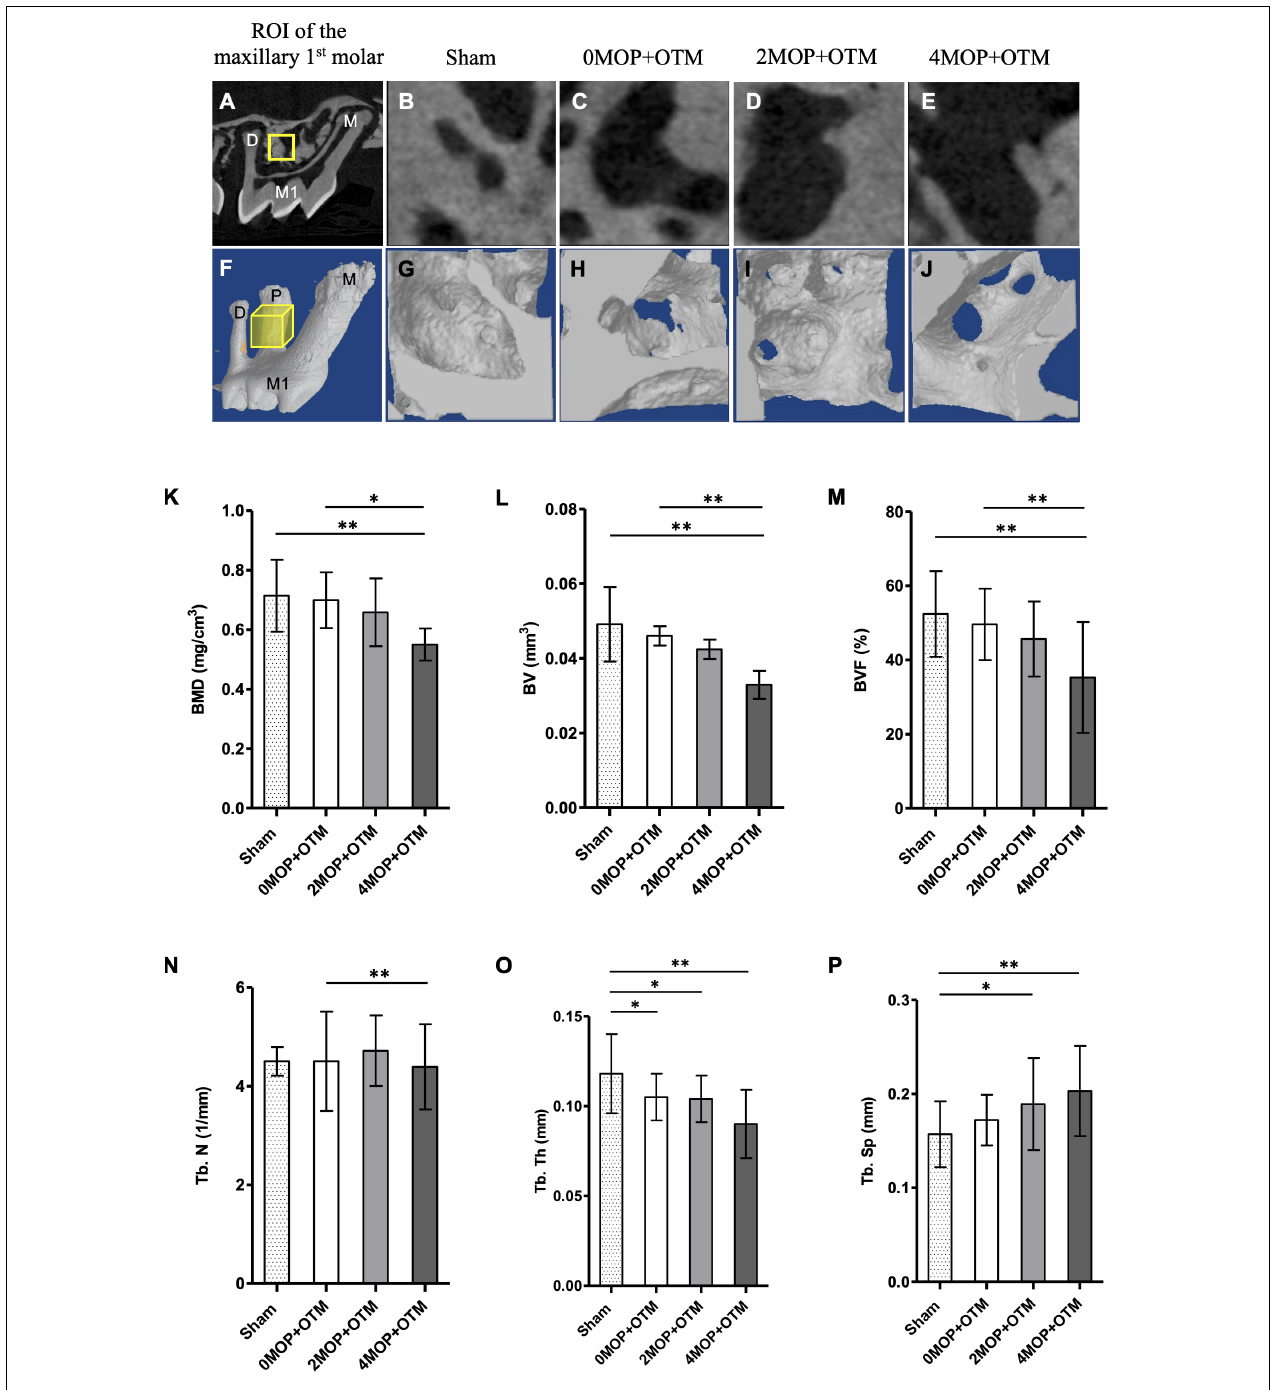
FIGURE 1 | Micro-CT analysis for bone quality. (A–E) Sagittal section image of micro-CT. The ROI (yellow square on A ) of alveolar bone quality for each group from (B–E) . (F–J) 3D reconstructed images of ROI (yellow cube on F ) of experimental groups. According to the volumetric analyses, (K) BMD, mg/cm 3 ; (L) BV, mm 3 ; (M) BVF, % decreased in the 4MOP+OTM group (0.55 ± 0.18 mg/cm 3 ; 0.03 ± 0.01 mm 3 ; 35.27 ± 14.94 %; p < 0.01) compared to the 0MOP+OTM group (0.69 ± 0.09 mg/cm 3 ; 0.04 ± 0.009 mm 3 ; 49.59 ± 9.62 %) and Sham group (0.71 ± 0.12 mg/cm 3 ; 0.04 ± 0.01 mm 3 ; 52.39 ± 11.55 %). (N) Additionally, the Tb. N, 1/mm was found to decrease in the 4MOP+OTM group (3.78 ± 0.89 1/mm; p < 0.01) compared to the 0MOP+OTM group (4.71 ± 0.71 1/mm). (O,P) Regarding changes in the Tb. Th, mm; Tb. Sp, mm were different between the 4MOP+OTM group (0.09 ± 0.01 mm; 0.20 ± 0.04 mm; p < 0.01) and Sham group (0.11 ± 0.02 mm; 0.15 ± 0.03 mm). In addition, the 2MOP+OTM group (0.10 ± 0.01 mm; 0.18 ± 0.04 mm; p < 0.05) was different compared with the Sham group. ( N = 12/each group) (M1, 1st molar; M, mesial; P, palatal; D, distal; data are expressed as mean ± standard deviation. Tested by Mann–Whitney U -test, at ∗ p < 0.05; ∗∗ p <